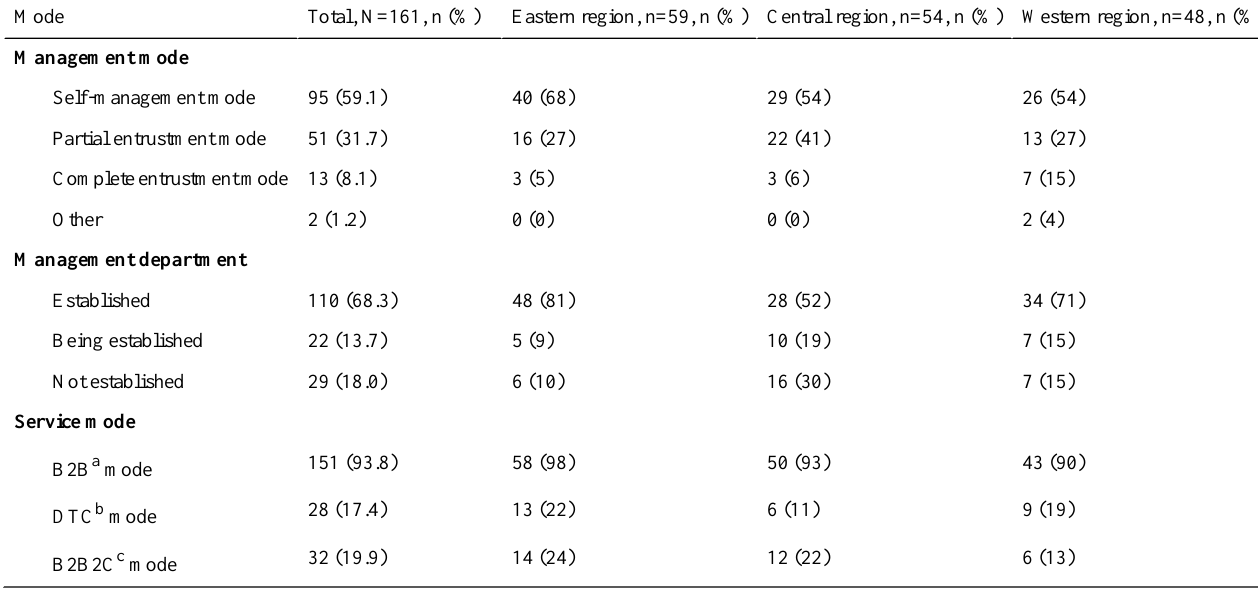
Table 3. Telemedicine management and service mode of tertiary hospitals in different regions of China